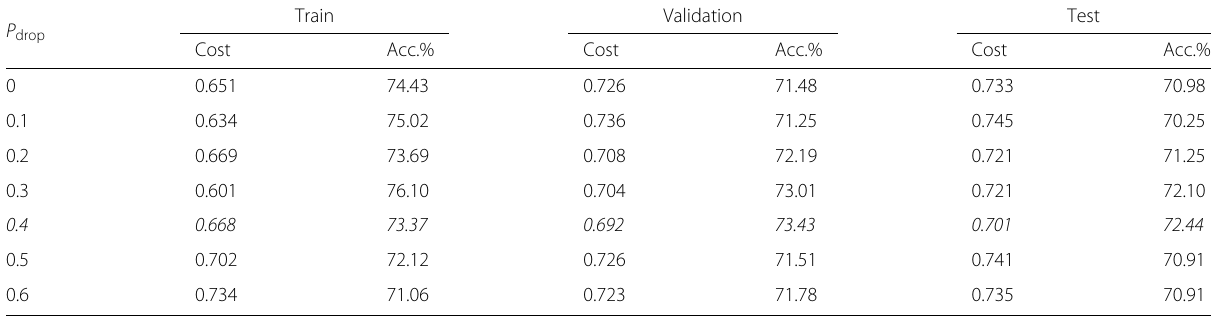
Table 8 Results of the P drop sweep using the best setting of the double-task network (C2-LSTM, L = 6, N = 256) P drop